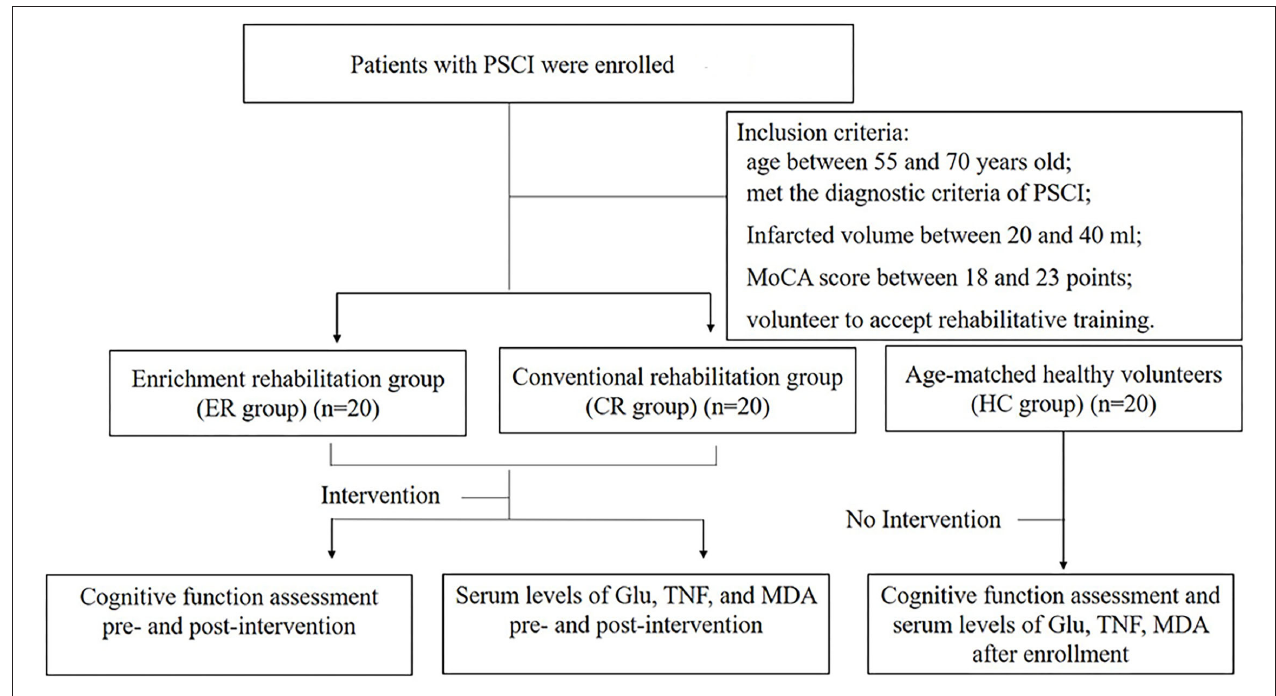
FIGURE 1 | Flowchart illustrating the process of the